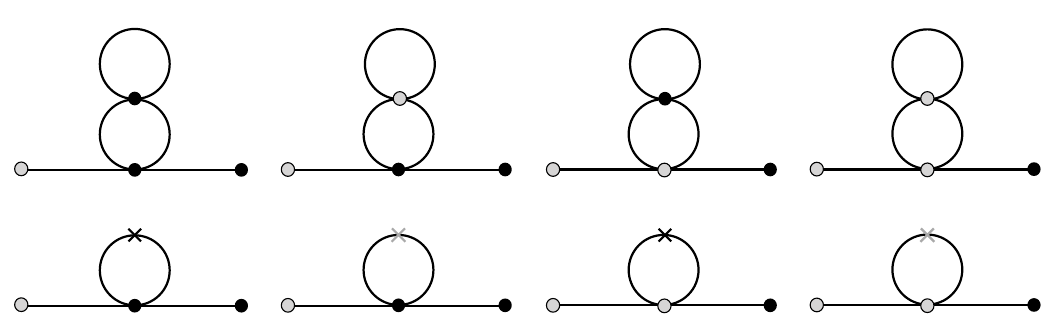
Figure 4 . (Top) Connected two-loop contributions of the ‘snowman’ type to the two-point corre- lation function in a λφ 4 theory. (Bottom) The corresponding δ m and/or δ r counterterm diagrams. figure 5. The contribution from the snowman diagrams is G − + ( t, t 0 ) = − k,λφ 4 , sm